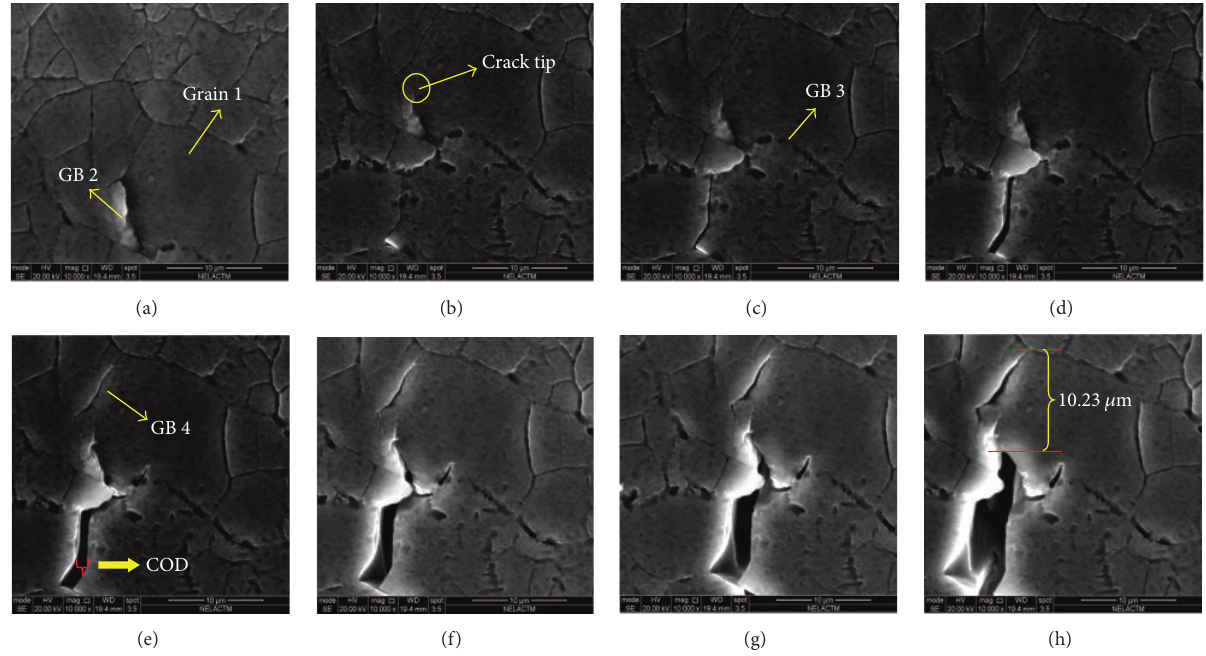
Figure 8: In the loading stage of 112 cycles, micromorphology of fatigue crack at different loading level: (a) at 175 N, (b) at 525 N, (c) at 700 N, (d) at 875 N, (e) at 1050 N, (f) at 1225 N, (g) at 1400N, and (h) at 1750 N.